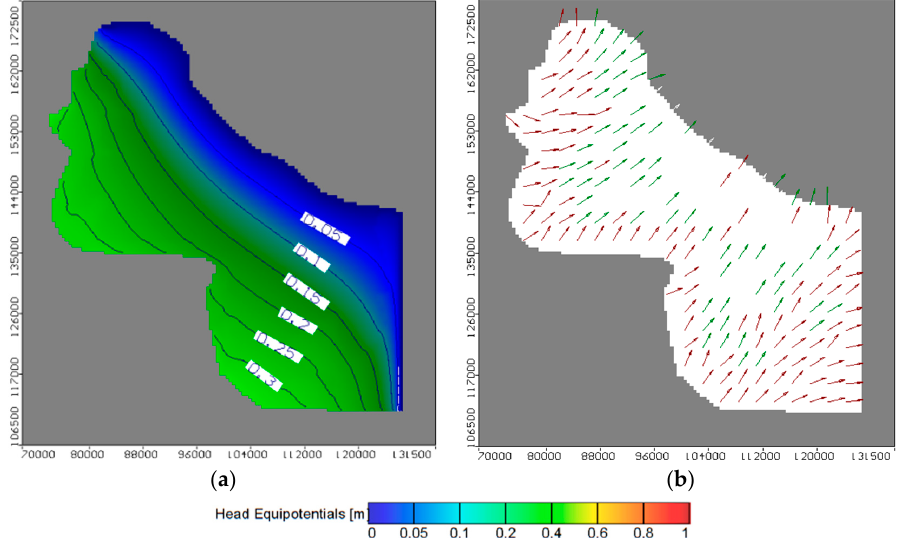
Figure 8. Arial view of the study area at base for ( a ) groundwater head and ( b ) velocity direction.